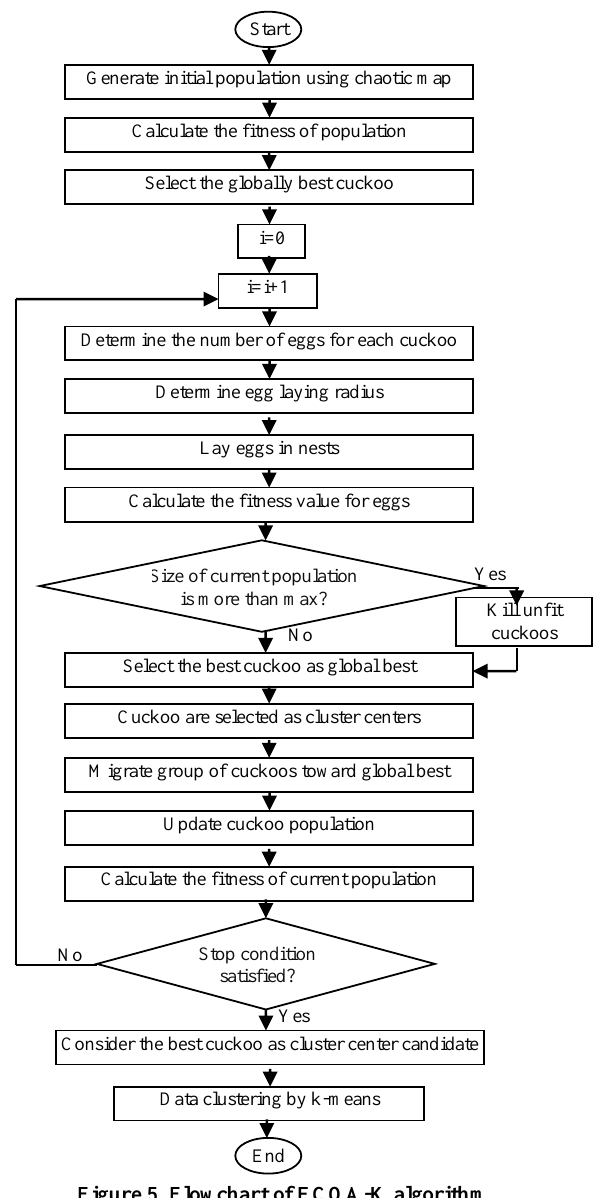
Figure 5. Flowchart of ECOA-K